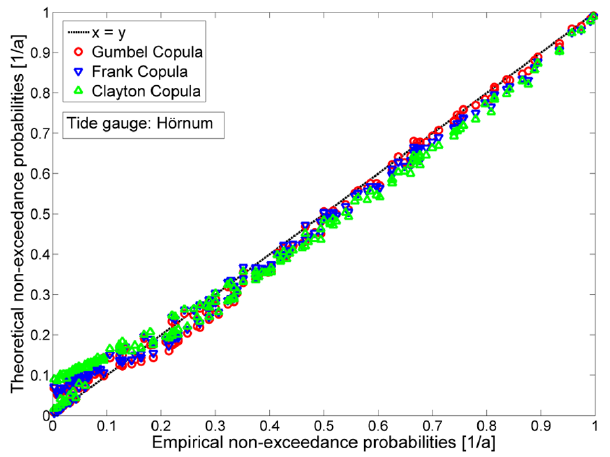
Fig. 7. Q-Q-plot for the tide gauge of H¨ornum with the theoretical and empirical joint exceedance probabilities of the observed storm surge events.